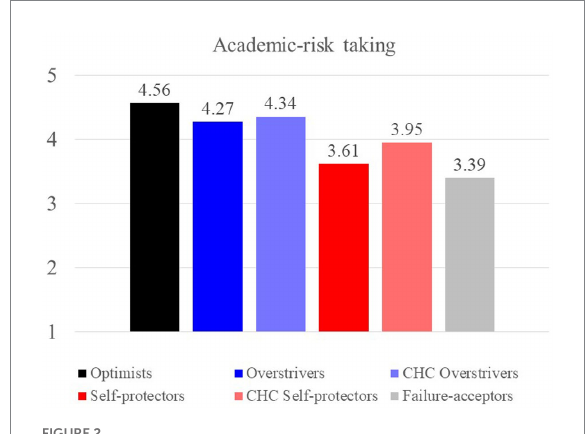
FIGURE 2 Academic-risk taking tendency across categories.